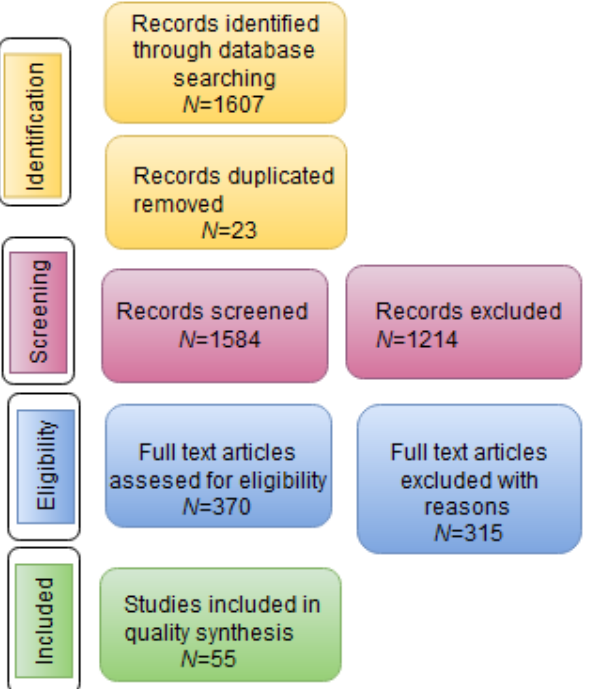
Figure 3. PRISMA methodology used in SLR process to identify factors in IoT devices that could affect security risk.